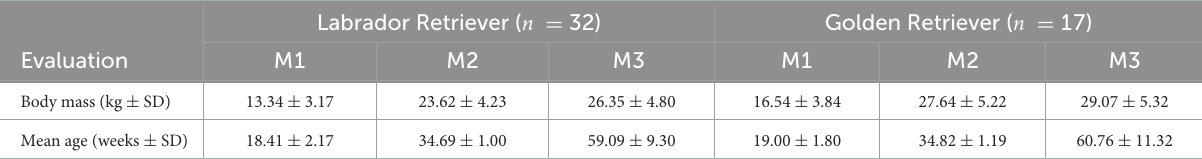
TABLE 1 Demographic data of the studied dogs at three measurement points (M1 = 4 months, M2 = 8 months, and M3 = 12 months of age). Labrador Retriever ( n = 32)